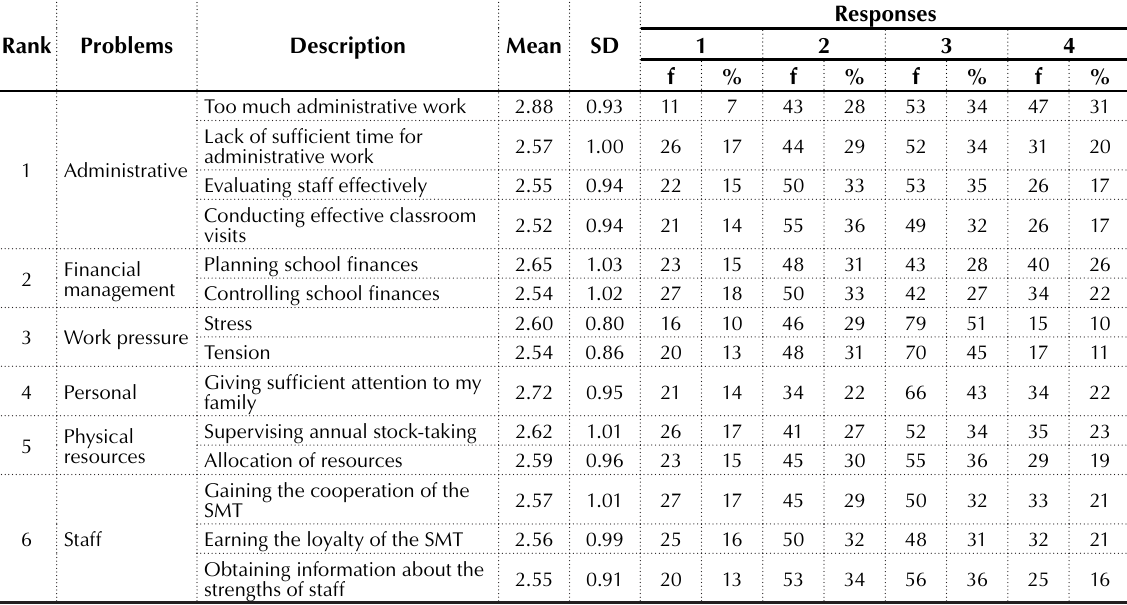
Table 3. Descriptive statistics of problems experienced by deputy